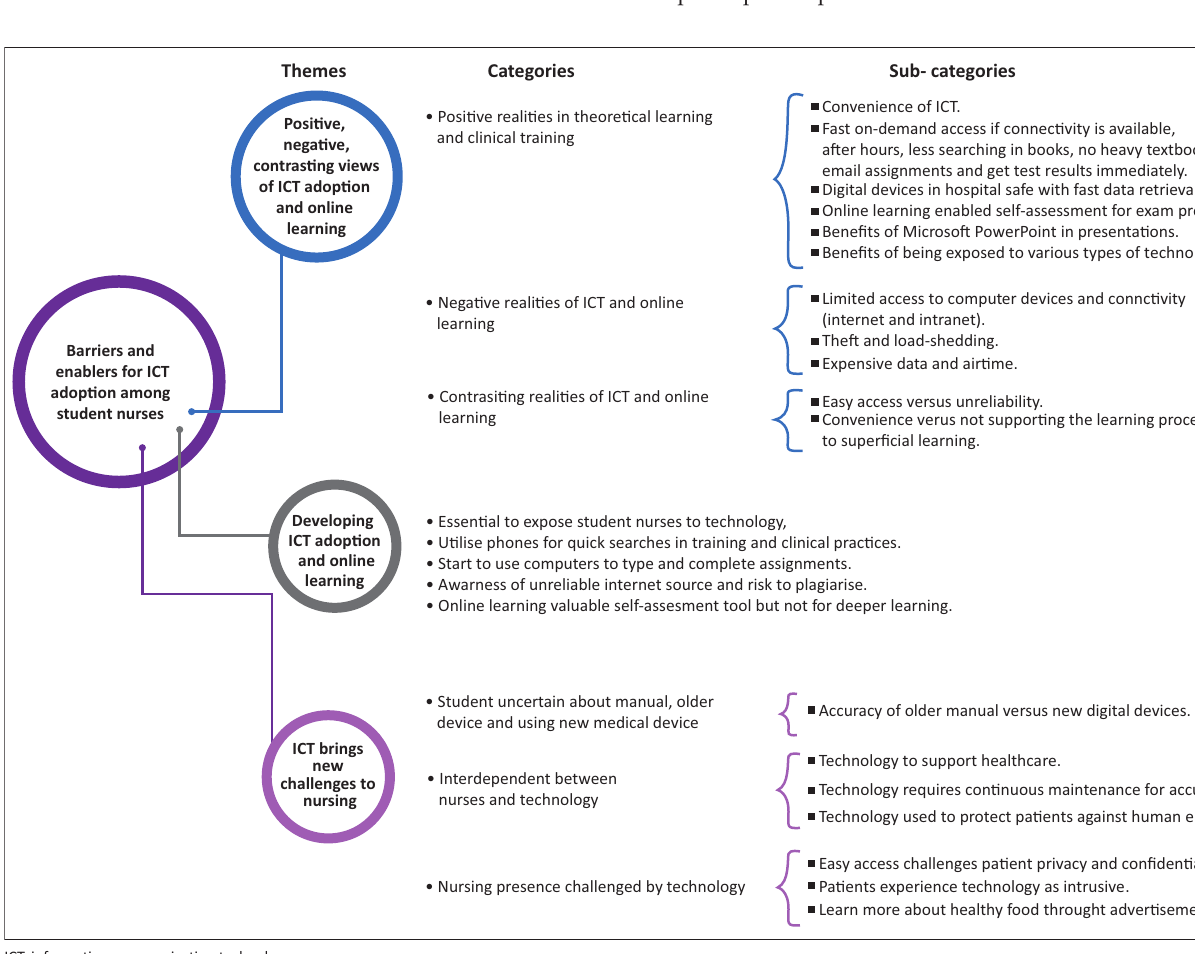
FIGURE 1: Themes, categories and sub-categories of the barriers to and enablers for ICT adoption by student nurses.